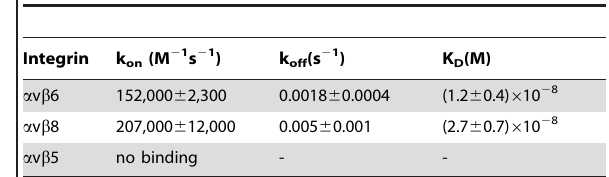
Table 1. Kinetic constants ( 6 SD) for gH/gL binding to soluble truncated